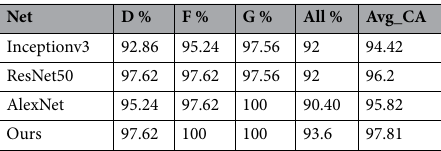
Table. 3. The classification accuracy of different pretrained networks and the proposed